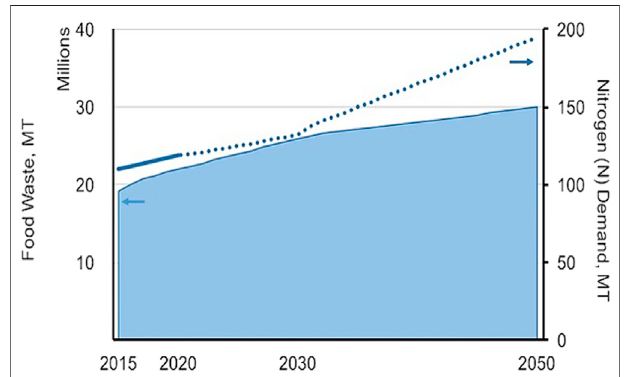
FIGURE 1 | Projected amount of FW and nutrient N demand from 2016 – 2050 (data from FAO, 2017; Read et al.,